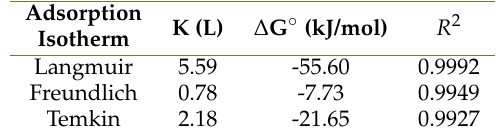
Fig. 10. Temkin isotherm plot for the inhibitor’s adsorption of CPP on mild steel surface in 1.0 M HCl at 24 hour immersion time. Table 3. Experimental design ranges of independent variables for CPP